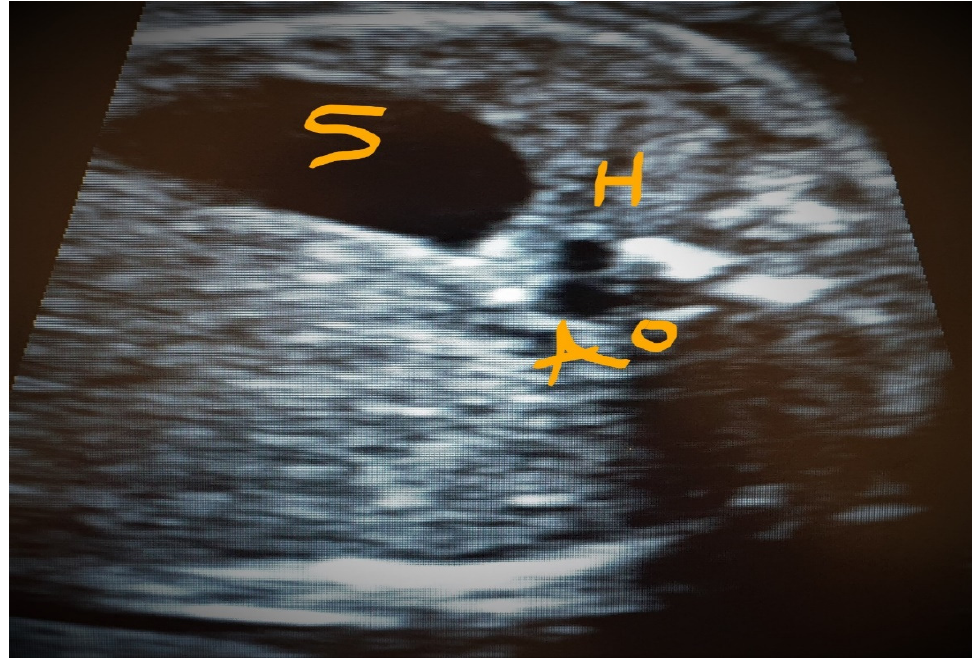
Figure 9. Transverse superior abdominal section showing two vessels side by side, S—Stomach, H—the hemiazygos vein and the aorta Ao.